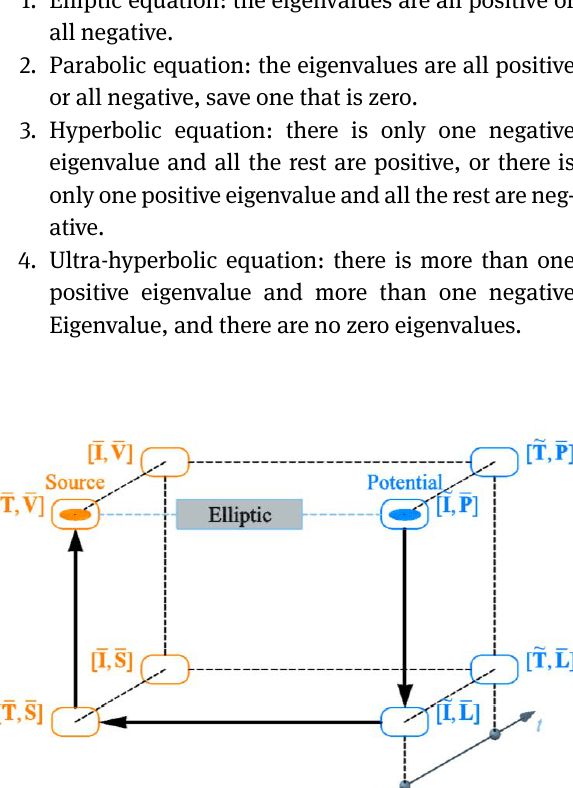
Figure 35: Elliptic equations in the classification